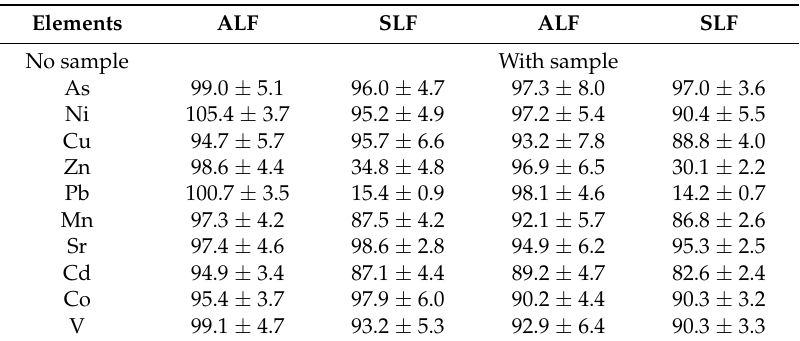
Table A2. Recovery percentages (%) for trace elements following spiking (after 24 h) for in vitro bioaccessibility tests conducted with ALF and SLF ( n =